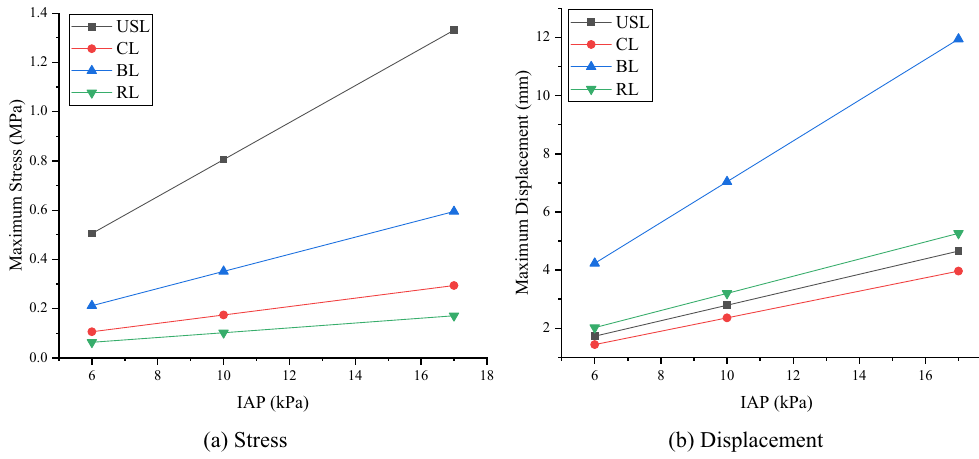
Figure 7. Changes of stress and displacement of ligaments under IAP. a Stress. b Displacement. (α = − 40º, created by OriginPro 2021, https:// www. origi nlab.